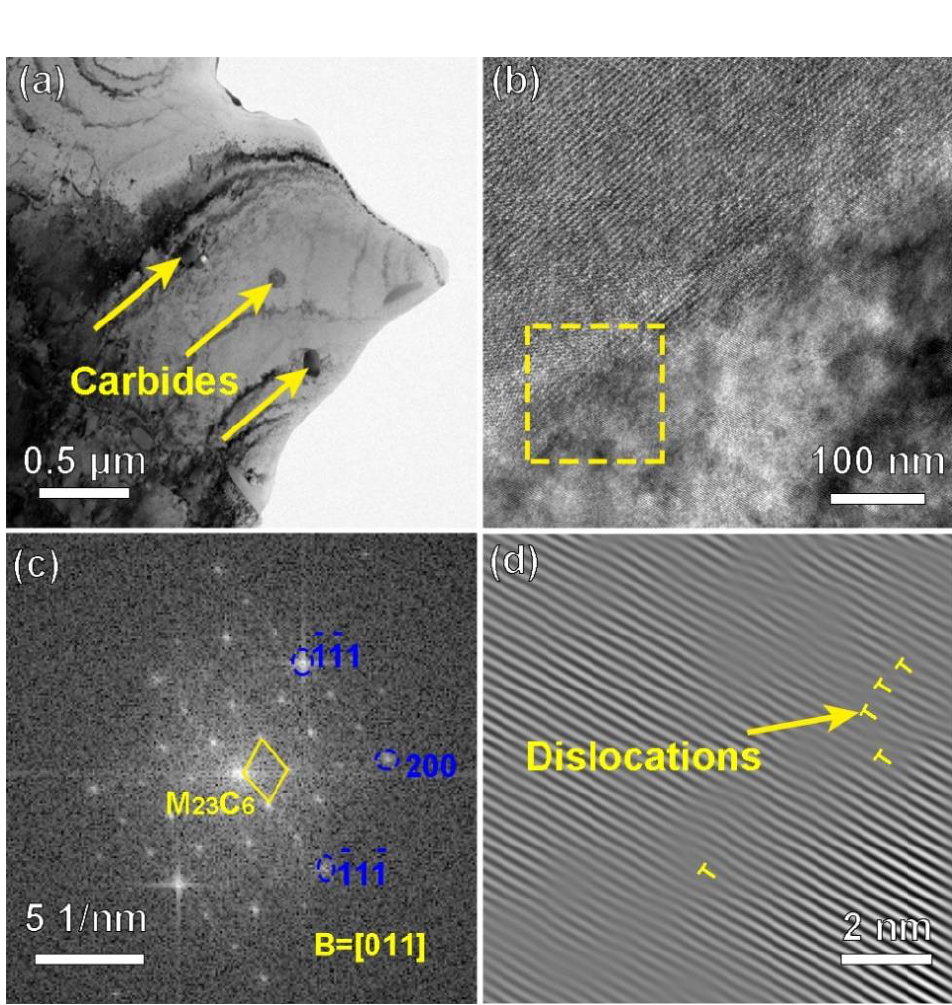
Figure 10. The TEM images showing the carbide in the CRHA. ( a ) the distribution of the carbide, ( b ) high-resolution image of the carbide/ γ interface, ( c ) fast Fourier Transform (FFT) of the yellow square area in ( b ) and ( d ) inverse fast Fourier Transform of ( c ). Table 4. Chemical compositions of carbides (at.%).